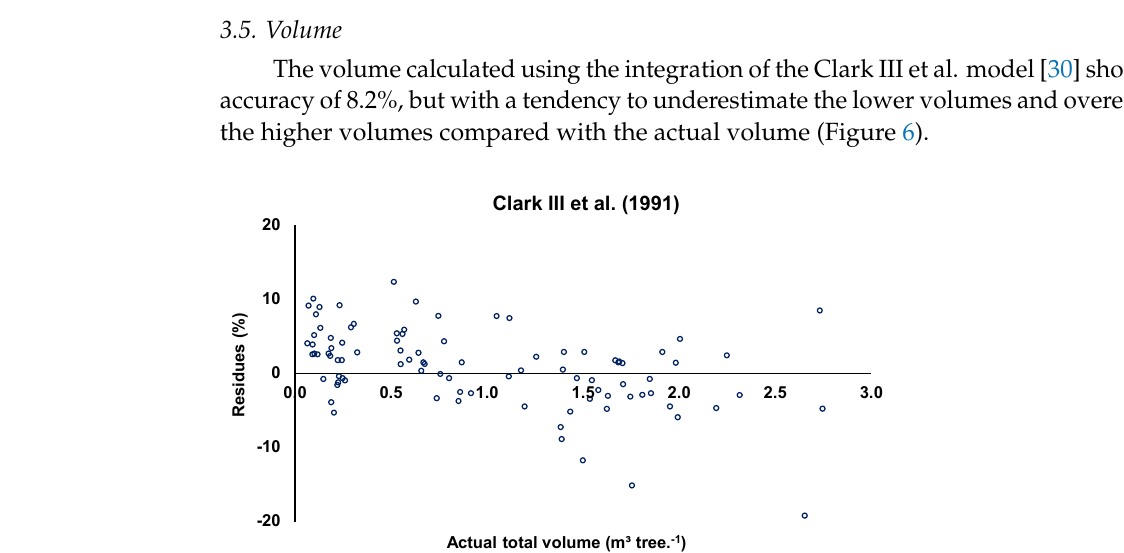
Figure 6. Residue of the total volume estimate using the Clark III et al. integral model as a function of the actual total volume for Tectona grandis L.f. data without stratification, central − western region, Brazil [30].